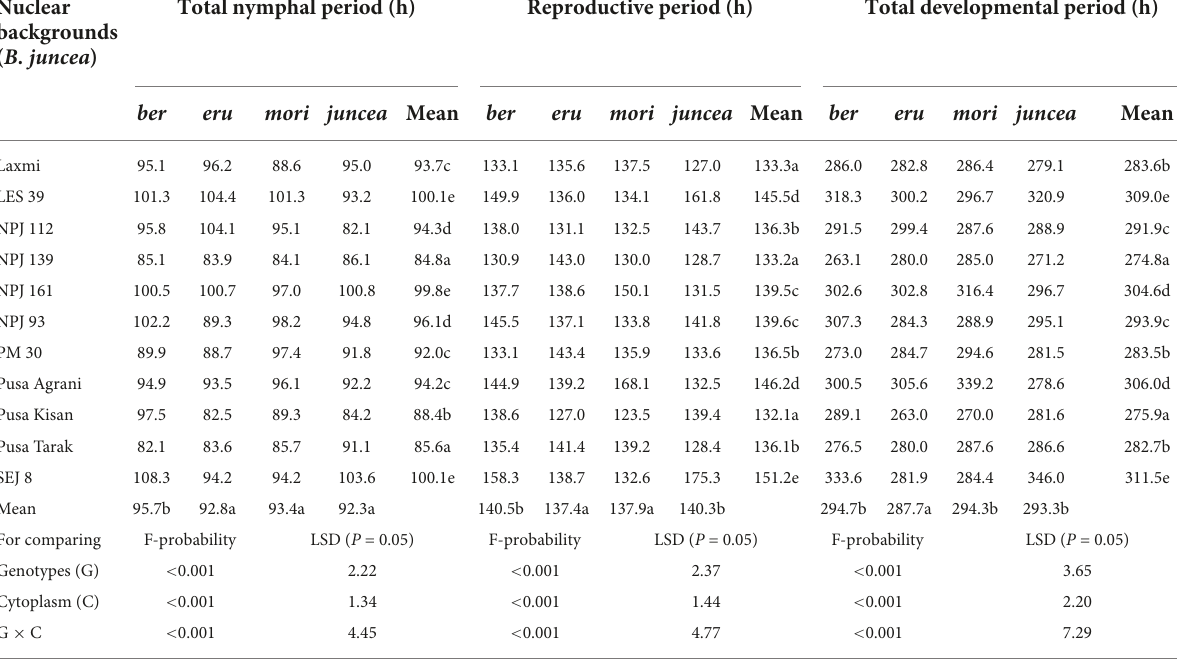
TABLE 2 Effects of cytoplasms and nuclear backgrounds on developmental and reproductive periods of Lipaphis erysimi in auto- and alloplasmic lines of Brassica juncea. Nuclear backgrounds ( B. juncea )